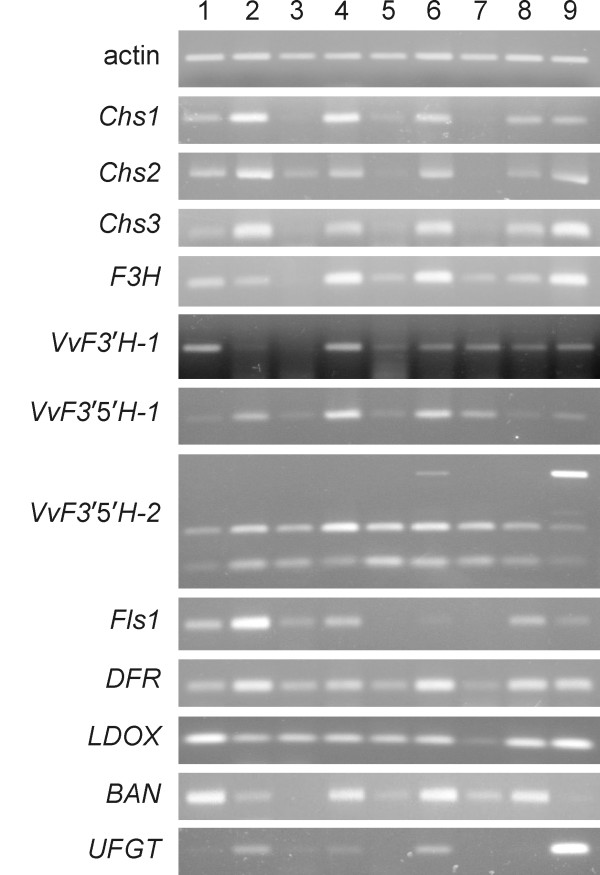
Expression of structural genes of the flavonoid pathway in different tissues. Expression profiles of flavonoid hydroxylase genes were analysed alongside nine major structural genes of the flavonoid pathway in the following tissues: 1, apex and apical leaflet (pale green); 2, apex and apical leaflets (reddish pigmented shoot tips); 3, fully expanded leaves; 4, immature flowers; 5, rootlets; 6, seeds; 7, berry flesh; 8, berry skin (pre-véraison, green); 9, berry skin (post-véraison, red). The actin gene was used as a constitutive gene for the normalisation of cDNA samples.